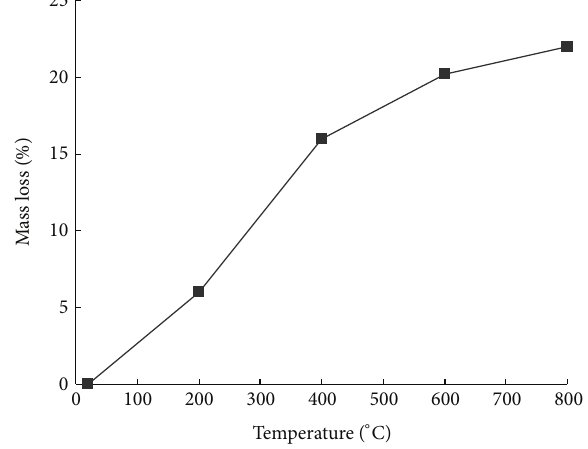
Figure 4: Mass loss of specimens of all curing ages with tempera-